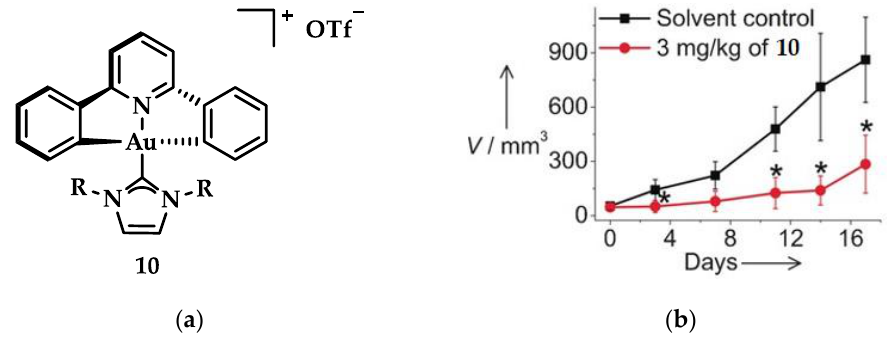
Figure 17. ( a ) Chemical structure of Au(III)-NHC pincer complex with R = n -butyl; ( b ) Antitumor activity in mice HeLa cells after treatment with 3 mg·kg −1 of 10 . * p < 0.05. Adapted with permission from Ref. [44]. Copyright (2017) Wiley-VCHVerlag GmbH&Co. KGaA,